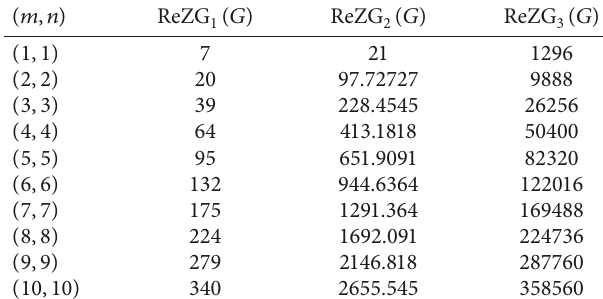
, ReZG , and ReZG 1 2